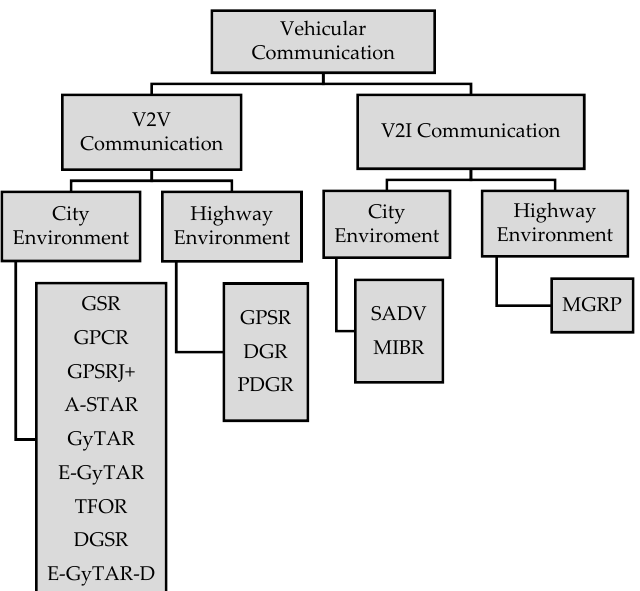
Figure 4. Categories of position based routing protocols. GSR: Geographic Source Routing, GPCR: Greedy Perimeter Coordinator Routing, GPSRJ+: Greedy Perimeter Stateless Routing Junction+,